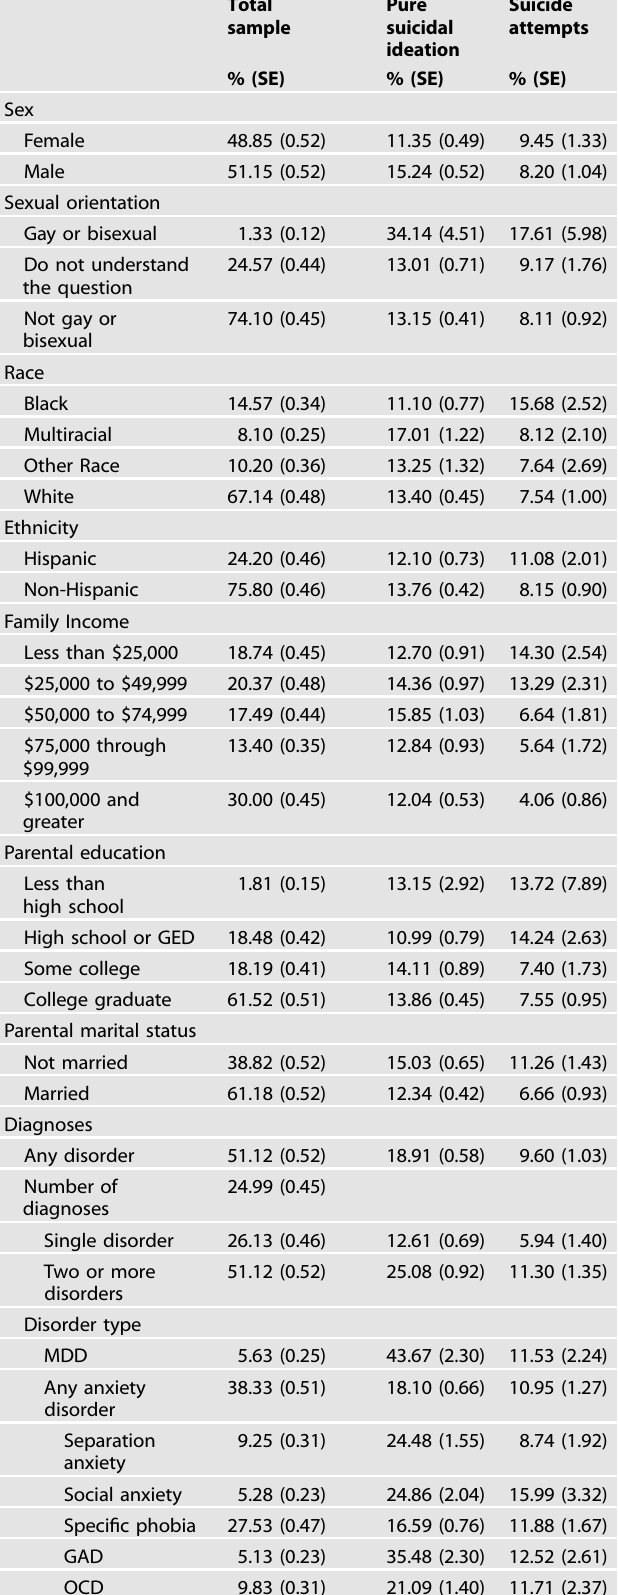
Table 1. Sociodemographic and clinical characteristics of the sample (unweighted N =